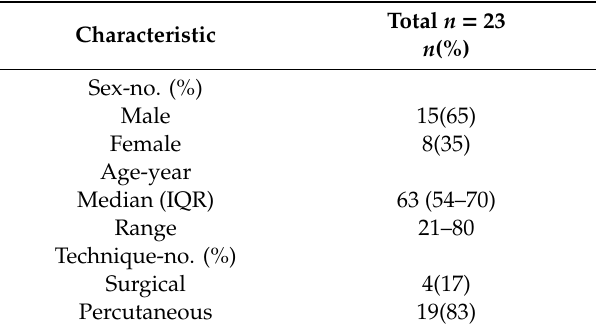
Table 1. Demographics and tracheostomy type.